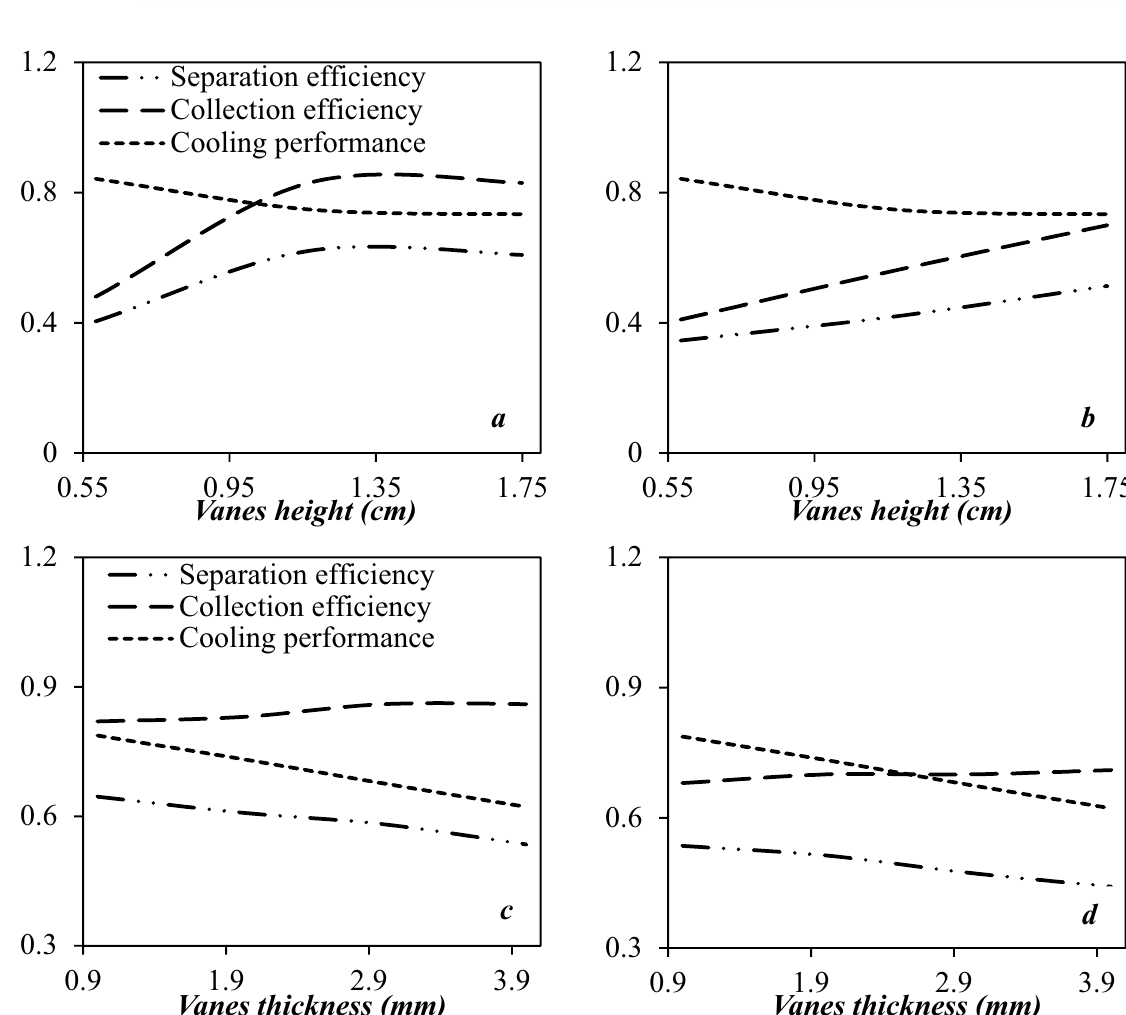
Figure 13. The influence of static vanes height ( a , b ) and static vanes thickness ( c , d ) on the collection efficiency, cooling performance and separation efficiency of 3S for ( a , c ) water droplets and ( b , d ) HC